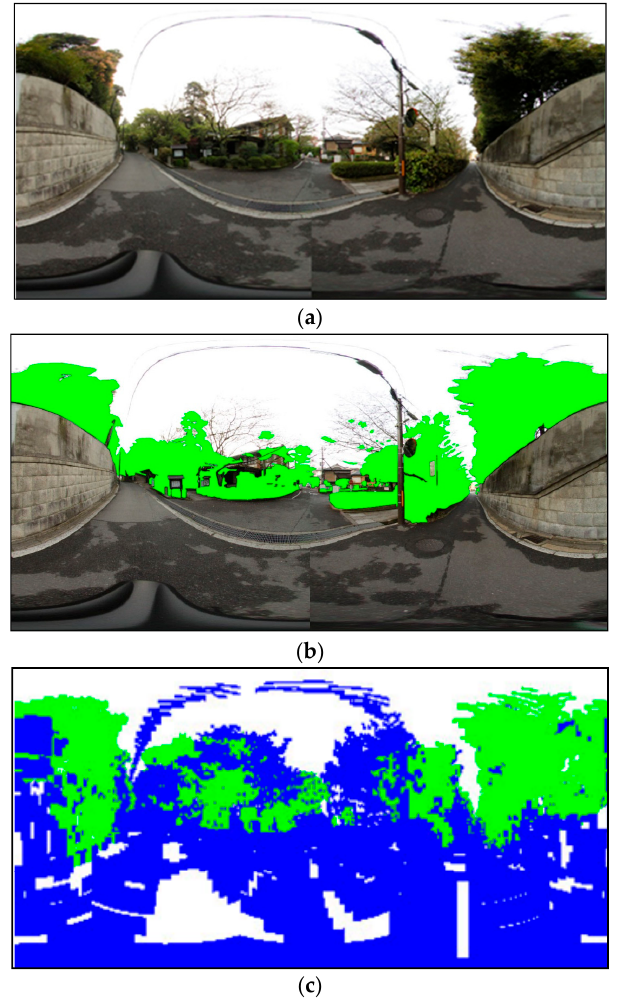
Figure 11. Comparison of ground truth and occlusion map at P8 (shown in Figure 1): ( a ) ground truth obtained from the images taken by a camera with a fisheye lens; ( b ) vegetation manually extracted from ( a ); and ( c ) occlusion map generated using the proposed method. ( b , c ) Green denotes vegetation. ( c ) Blue and white denote non-vegetation and others, respectively. ( b ) Actual GSR = 17.0%. ( c ) Estimated GSR = 20.2%.